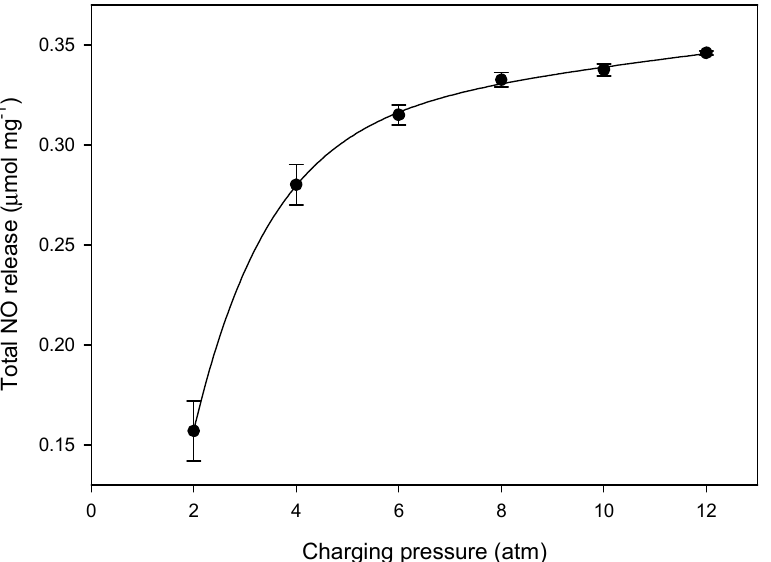
Figure 9. Plot of total NO release of NO ⊂ micro-Cu-BTC 3 in deoxygenated phosphate-buffered saline (PBS, 0.01 M, pH 7.4) at 37 °C as a function of varying NO charging pressure. Table 2. NO release properties of NO ⊂ Cu-BTC a,b .